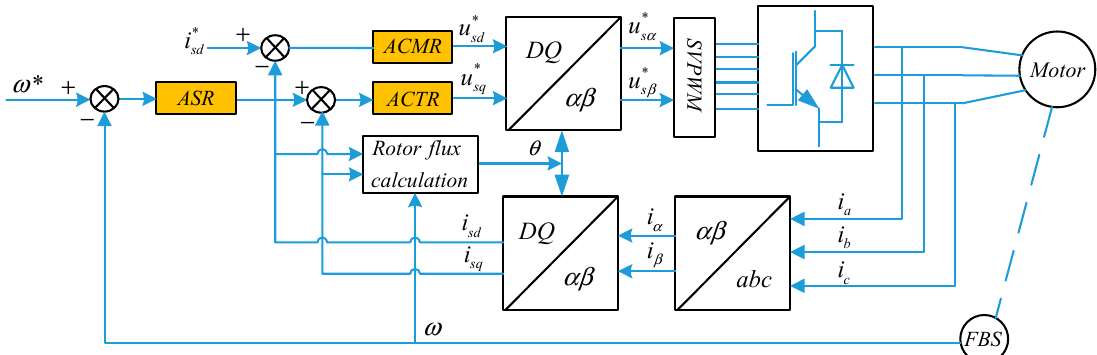
Figure 3. Vector control structure of an asynchronous motor. ASR: automatic speed regulator, ACTR: Automatic torque current regulator, ACMR: Automatic magnetic field current regulator SVPWM: Space Vector Pulse Width Modulation.